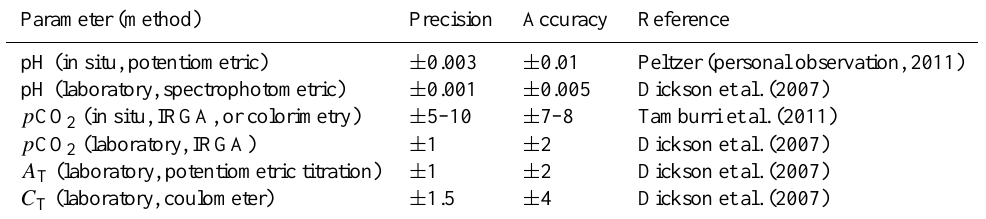
Table 4. Precision and accuracy of the measurements of carbonate chemistry parameters based on various in situ or laboratory techniques. p CO 2 is in µatm, A T and C T are in µmolkg − 1 . IRGA: infrared gas analyzer. Parameter (method) Precision Accuracy pH (in situ, potentiometric)